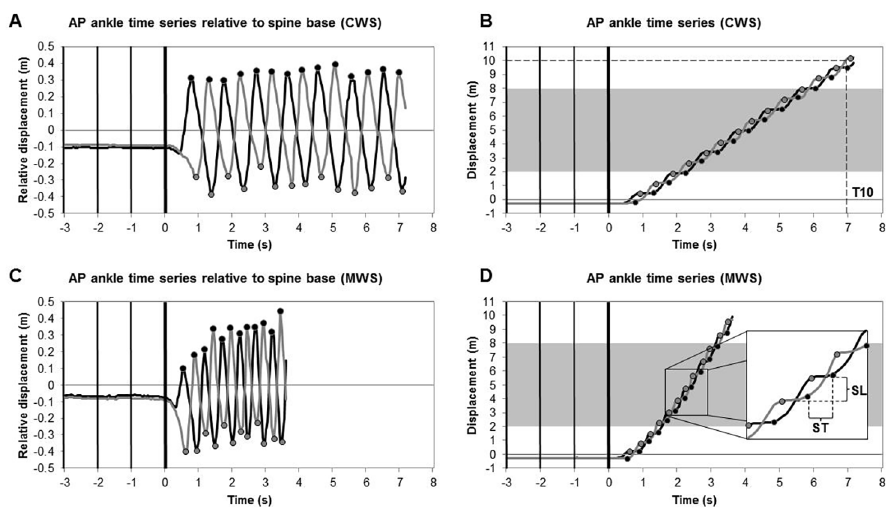
Fig 4. Overview of the analysis of spatiotemporal gait parameters. Analyses for CWS (panels A and B) and MWS (panels C and D) conditions are based on AP displacement data of the right (gray lines) and left (black lines) ankles as a function of time for the multi-Kinect v2 set-up. AP ankle time series relative to the spine base (panels A and C) were used to estimate instants of foot contact (black dots) and foot off (gray dots) for each step. Step location was defined as the median value of the AP ankle time series during the single-support stance phase (i.e., the horizontal plateaus delimited by foot off and foot contact events of the contralateral foot in panels B and D). Vertical bars represent the four beep onsets of the auditory start command. The shaded area in panels B and D represent the 6-meter window from which spatiotemporal gait parameters were derived. Dashed lines in panels B and D schematically define the time to walk 10 meters (T10), step time (ST) and step length (SL).